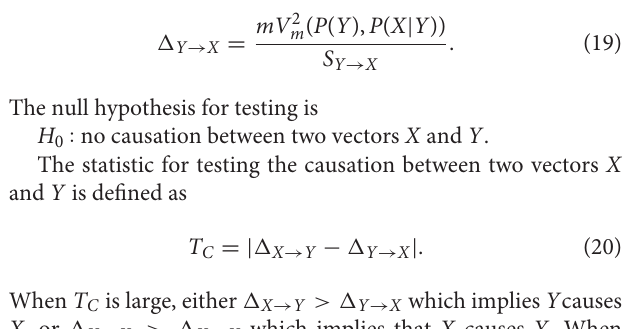
(12,12). Simulation scenario 2, (|X|,|Y|) =